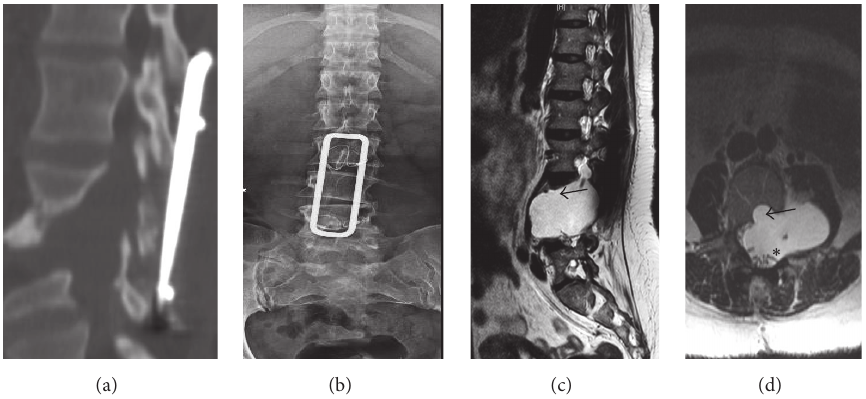
Figure 2: Postoperative CT and X-rays (a and b) showing L3 hemilaminectomy and L2–L5 stabilization with Hartshill rectangle and titanium wire. One-year follow-up after the first operation, sagittal and axial T2-weighted MRI images (c and d) disclosed a relapse of the operated pseudomeningocele at L3-L4 level with vertebral body remodelling (black arrow) and spinal roots displacement and convolution